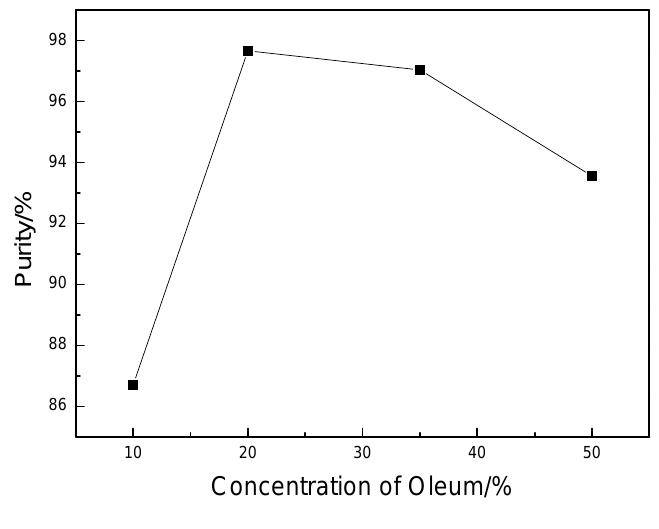
Figure 1. Influence of the oleum concentration